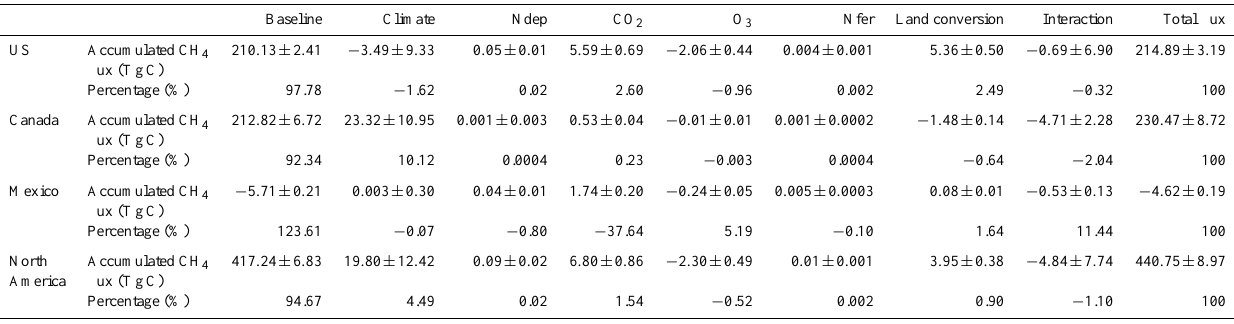
Table 4. Factorial contributions to the accumulated CH 4 from 1979 to 2008.